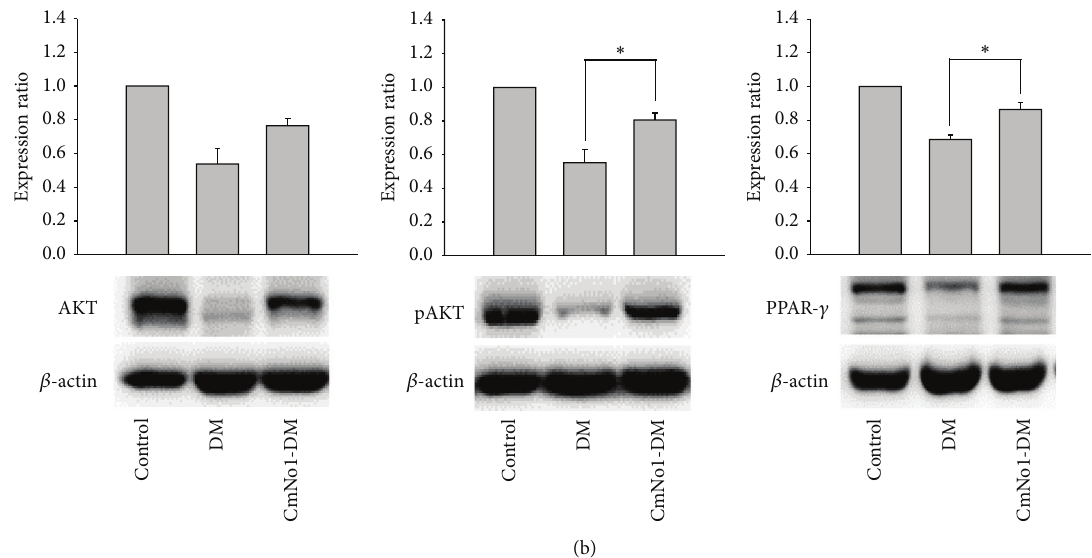
Figure 5: Specific protein expression of skeletal muscle and adipose tissue. (a) The protein expression of insulin receptor substrate-1 (IRS-1), phosphorylated IRS-1 (pIRS-1), protein kinase B (AKT), phosphorylated AKT (pAKT), and glucose transporter type 4 (GLUT-4) in skeletal muscle was measured. 𝛽 -actin was used as a loading control in Western blot analysis and the measurement was expressed as a ratio of specific protein/ 𝛽 -actin expression. (b) Analysis for IRS-1, pIRS-1, AKT, pAKT, GLUT-4, and peroxisome proliferator-activated receptor 𝛾 (PPAR- 𝛾 ) in adipose tissue. Data is expressed as the means ± SEM of 𝑛 = 6 samples. Symbols specify significant difference from DM with ∗ and ∗∗ indicating 𝑝 < 0.05 and 𝑝 < 0.01 , respectively.